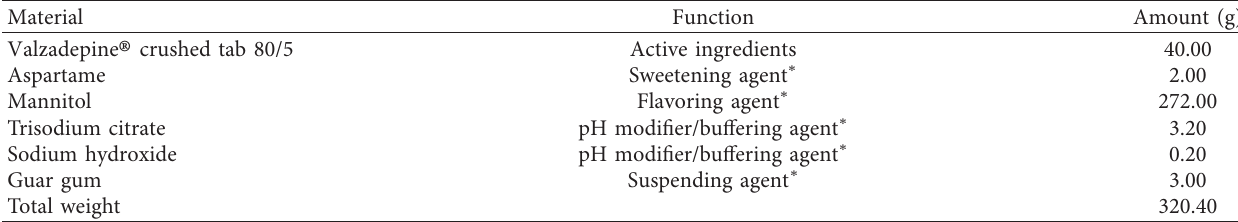
Table 1: The composition of the AML/VAL 5/80 suspension formula ∗